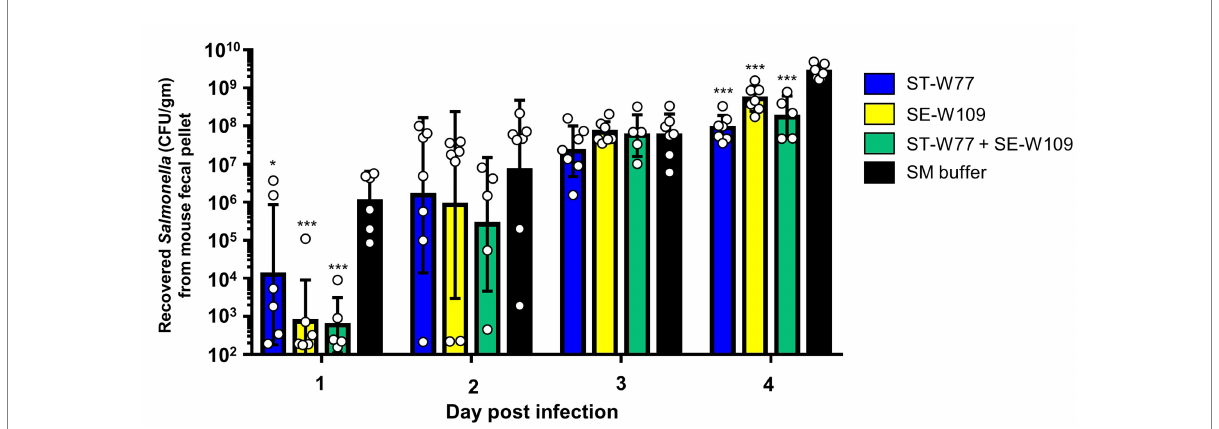
FIGURE 3 Oral feeding of phages (ST-W77 and SE-W109) reduced Salmonella shedding in mouse feces. The streptomycin-pretreated mouse colitis model of acute non-typhoidal salmonellosis was used. Orally treatment with phages (10 10 PFU/mouse) was started 1 h after S. Tm infection and once daily for three consecutive days. On days 1, 2, 3, and 4 p.i., mouse fecal pellets from all groups, including ST-W77, SE-W109, and combination (ST- W77 + SE-W109), were collected for S. Tm CFU/gm. Bars represent the geometric mean; error bars indicate geometric standard deviation.* and *** indicated p < 0.01 and 0.001, respectively, compared to the SM buffer-treated group (black bar).